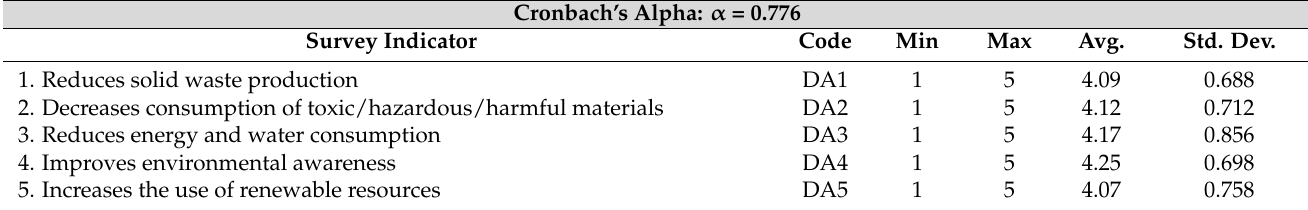
Table 6. Descriptive statistics of the variable “Environmental Performance” survey